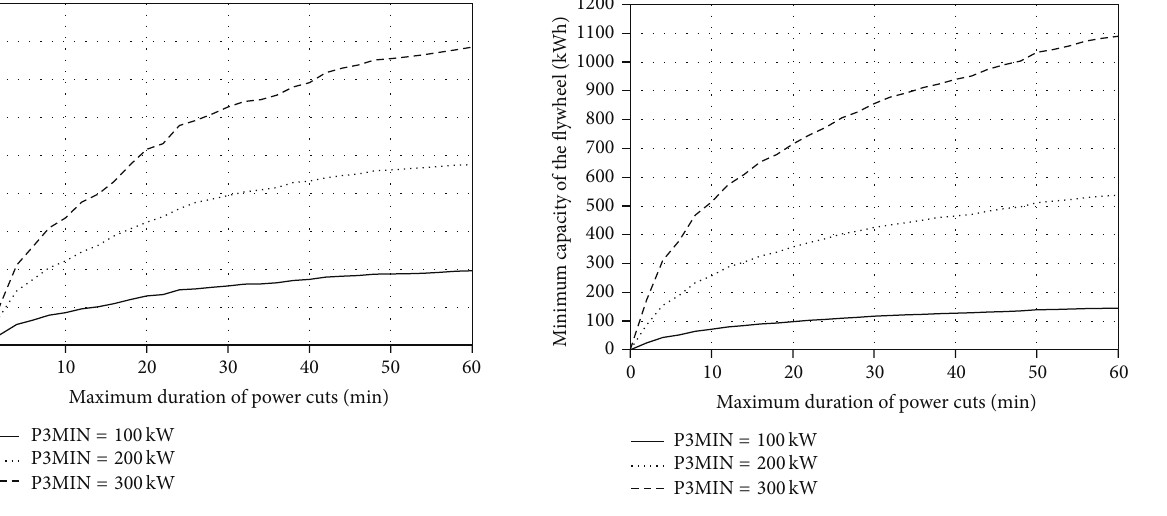
Figure 5: Family of characteristics 𝐴 E53 turbine, height: ℎ 𝑤 = 60 m for the period between 1 Jan. 2010 and 31 Mar. 2010.